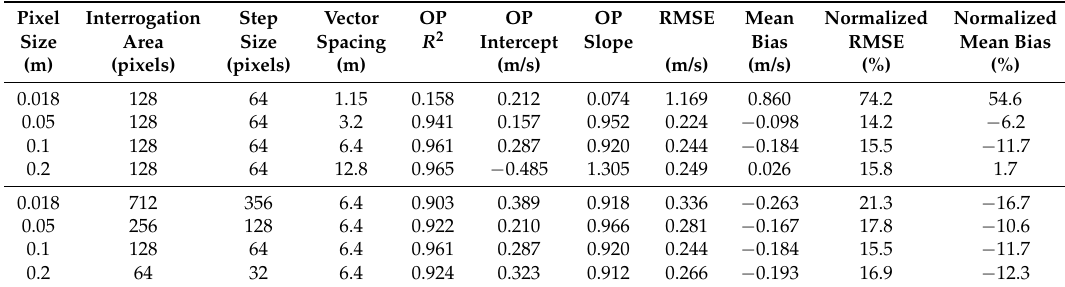
Table 3. Summary of PIV results from the Salcha River 2018 data set. OP = Observed versus Predicted; RMSE = root mean squared error; bias is calculated as ADCP–PIV; RMSE and bias are normalized by the mean velocity recorded by the ADCP (1.58